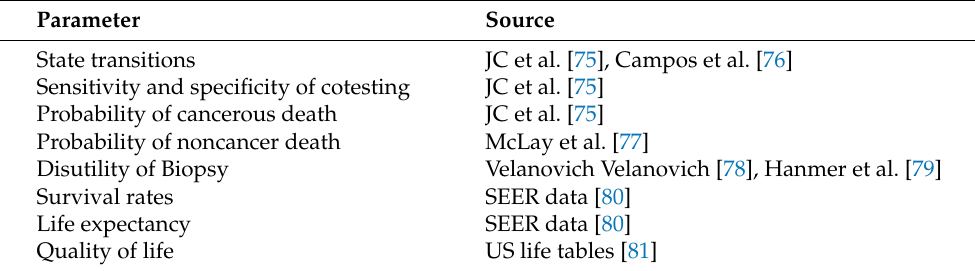
Table A1. Source of model